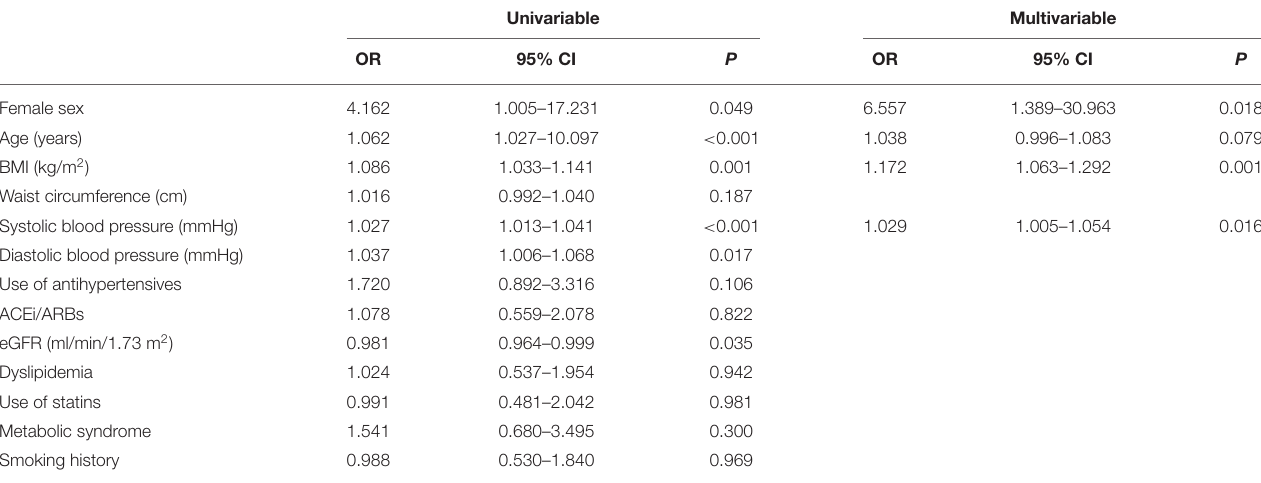
TABLE 3 | CVD risk factors significantly associated with the presence of LVH at follow-up: univariable and multivariable Cox regression